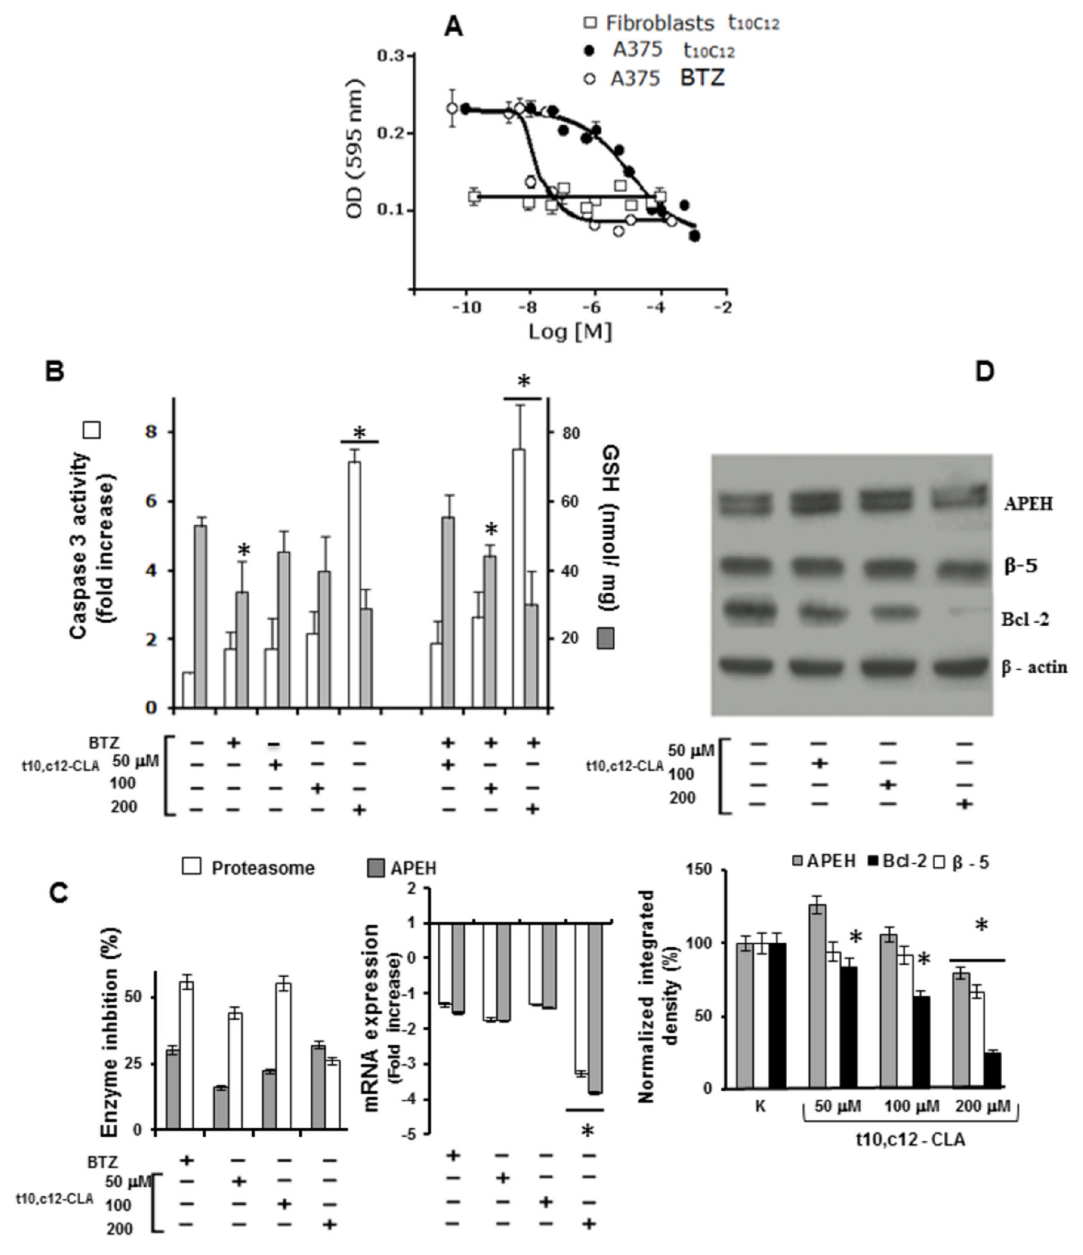
Figure 5. Dose-dependent pro-apoptotic activity of t10,c12-CLA correlates with down-regulation of GSH, APEH and proteasomal CT-like subunit at both mRNA and activity level in A375 cells. Isobologram of A375 cells treated with t10,c12- CLA or BTZ for 24h is reported in panel A. Human fibroblasts exposed to the same t10,c12-CLA concentrations were used as control. Data are expressed as means ±SD values of triplicate data from three independent experiments. Pre-confluent A375 cultures were incubated for 24h with 50, 100 or 200 µM t10,c12-CLA. Thereafter, cells were harvested, and used for cytoplasmic or mRNA extracts preparation. Cells untreated or treated with 10 nM BTZ were used as negative or positive controls, respectively. Measurement of GSH concentration (B), caspase 3 activity (B) and APEH or proteasomal CT-like activities (C left panel) were performed on cytoplasmic extracts. The mRNA levels of APEH and β-5 subunit were evaluated by qRT-PCR and expressed as fold change in comparison to untreated cells (C right panel). Intracellular levels of Bcl-2, APEH and β-5 were detected by immunoblotting (D upper panel). Data on Western blot analysis were normalized to the density of control (β-actin) and the values were expressed as percent value as compared to untreated cultures (K) on triplicate measurements (D lower panel). Results were presented as means ±SD of triplicate data from three independent experiments. *Significantly different (P < 0.01) from respective controls. doi: 10.1371/journal.pone.0080900.g005 PLOS ONE |